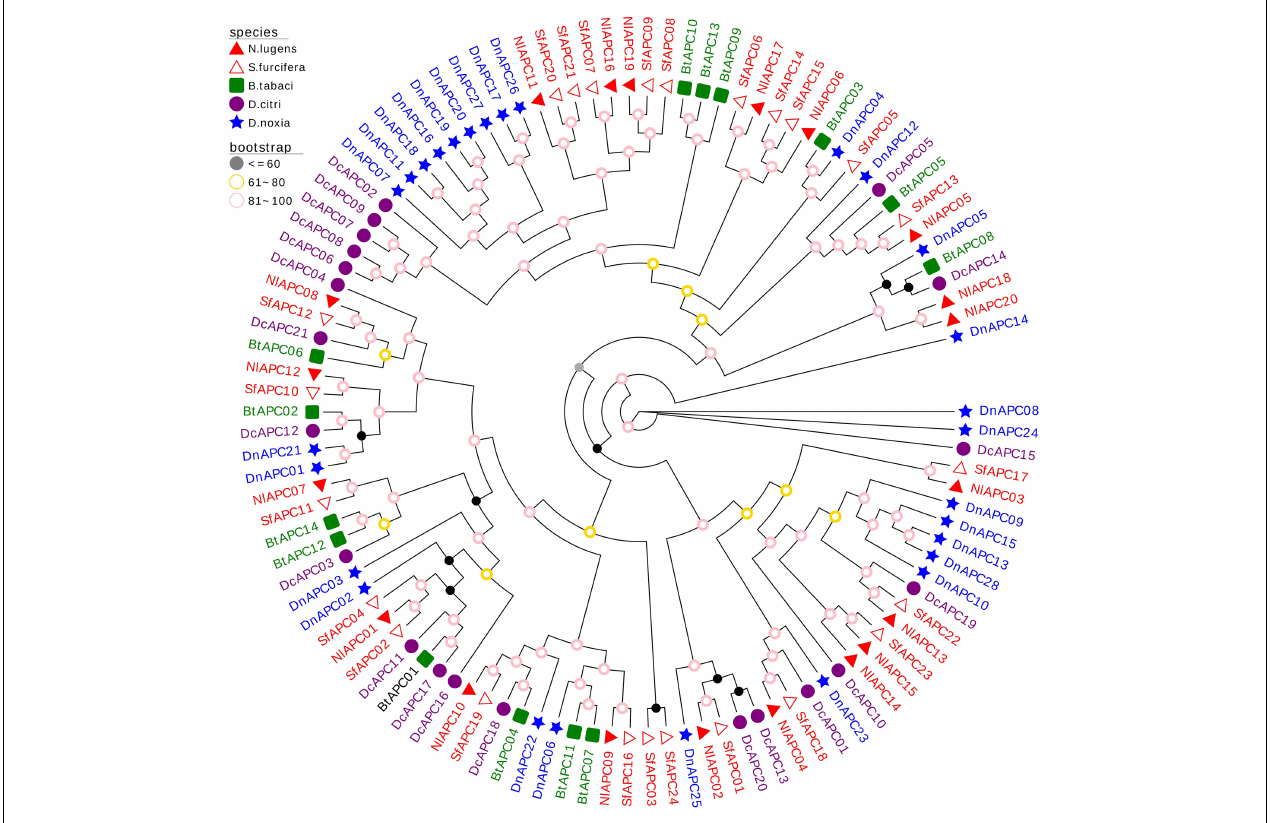
FIGURE 4 | Molecular phylogenetic analysis of 107 APC transporters from five hemipteran species, including Nilaparvata lugens (20), Sogatella furcifera (21), Bemisia tabaci (14), Diaphorina citri (24), and Diuraphis noxia (28). The phylogenetic tree was constructed through the Maximum- likelihood (ML) method with 1,000 bootstrap replicates, using the best-fit model of VT + R10 in IQ-Tree software version 2.0. The APC genes from the same family (Delphacidae, Aleyrodidae, Psyllidae, and Aphididae) of insect were marked with the same